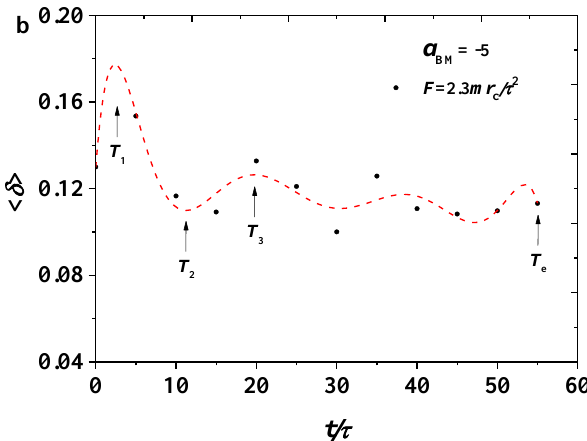
Figure 3. Variation of the shape factor δ for the bottlebrush polymers in the weak adsorption cases of 𝑎 BM = −5 , where the red dotted lines are the fitting results with ( a ) the pulling force of F = 1.7 mr c / τ 2 and ( b ) the pulling force of F = 2.3 mr c / τ 2 , respectively.